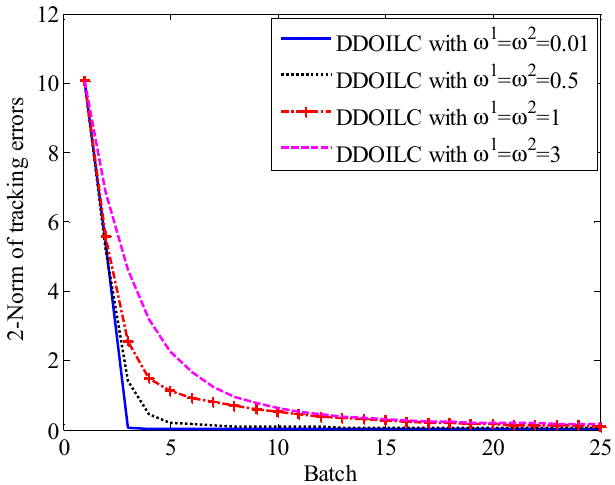
Figure 3. The convergences of the tracking errors of the DDOILC.